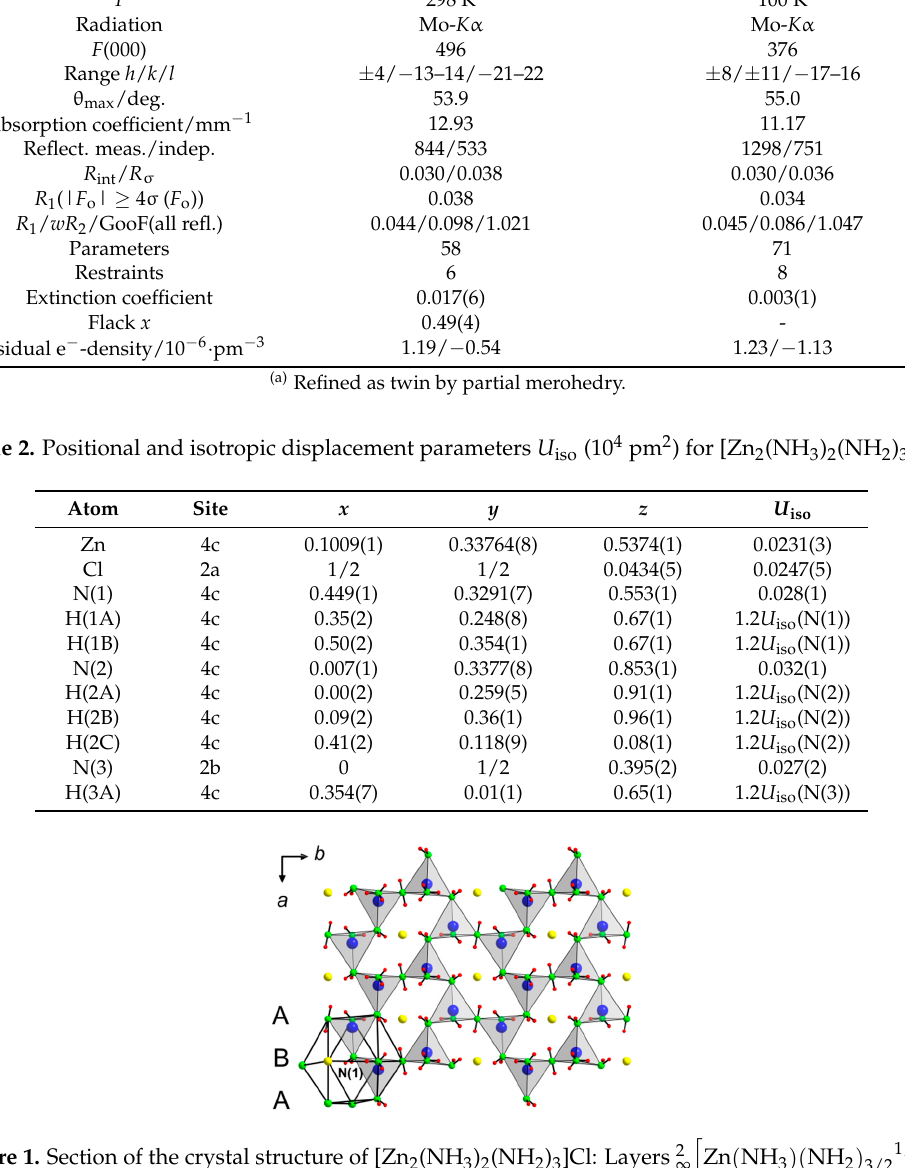
Figure 1. Section of the crystal structure of [Zn 2 (NH 3 ) 2 (NH 2 ) 3 ]Cl: Layers 2 ∞ [Zn 2 (NH 3 ) 2 (NH 2 ) 3 ] built by occupation of tetrahedral voids exclusively formed by amide and ammonia molecules by Zn within the motif of an hcp of chloride (closed packed layers in stacking direction [100] are indicated by letters A and B), amide ions and ammonia molecules ( yellow spheres: Cl, green spheres: N, red spheres: H, and blue spheres surrounded by grey tetrahedra: Zn). The hcp stacking motif is indicated by an anticuboctahedron and capital letters. Table 1. Selected crystallographic data and information for the structure determination of